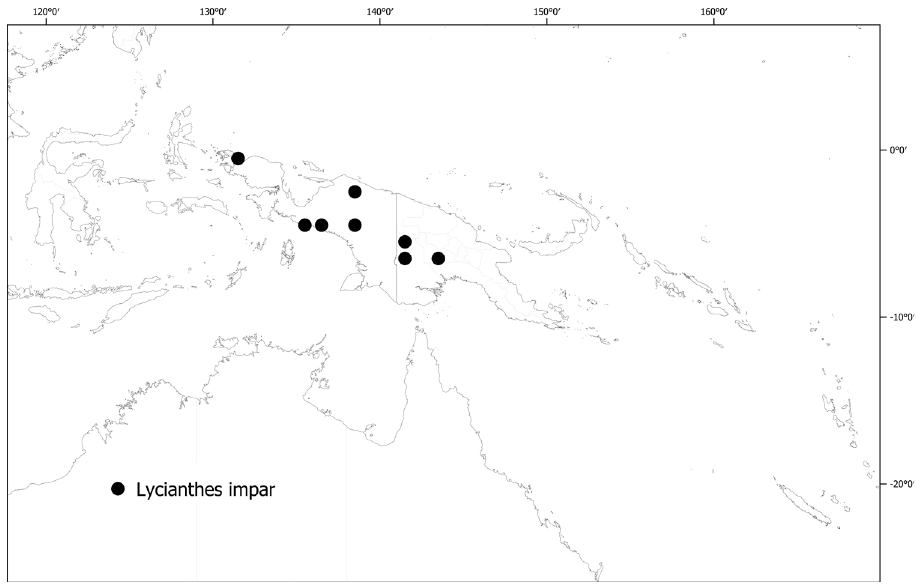
Figure 24. Distribution of Lycianthes